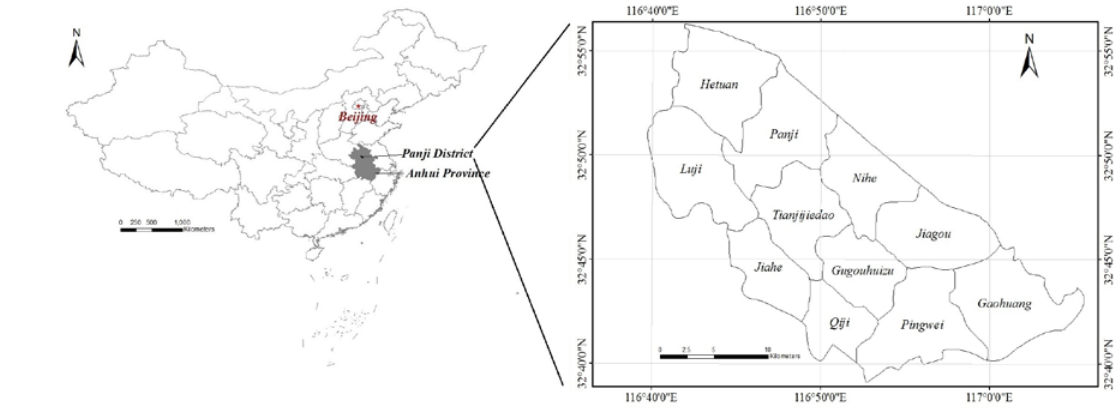
Figure 1. Location of study area.